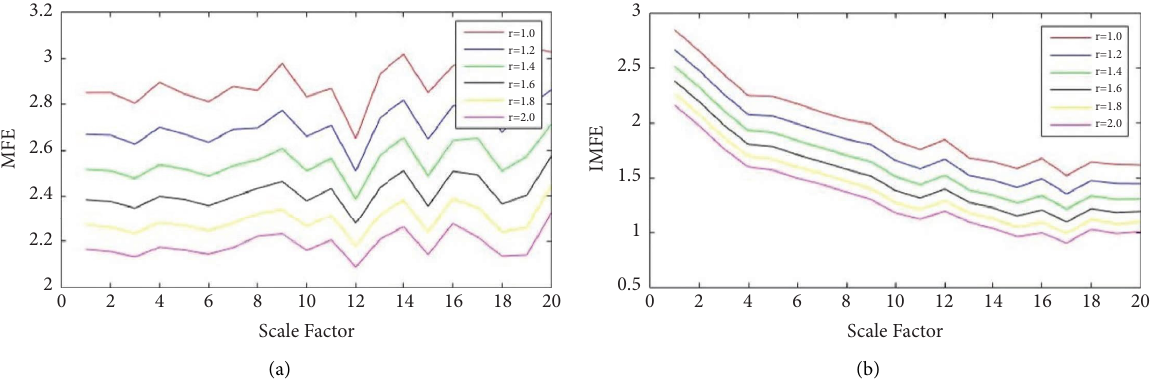
Figure 3: MFE and IMFE of Gaussian white noise with diferent r . (a) MFE of Gaussian white noise with diferent r and (b) IMFE of Gaussian white noise with diferent r .